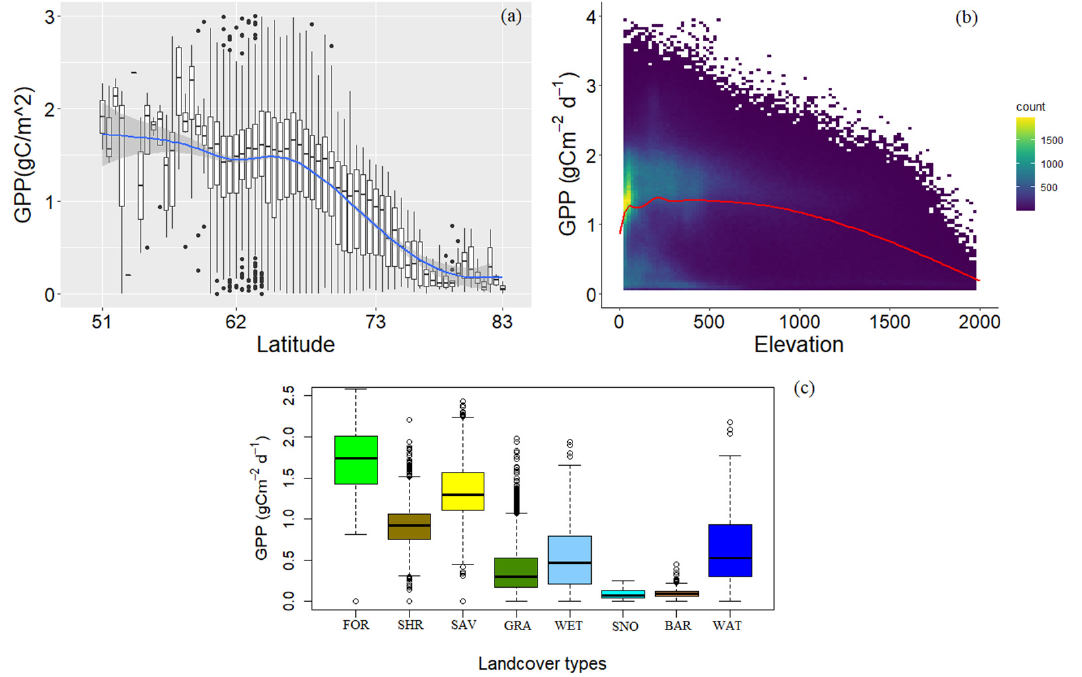
Figure 11. The annual-averaged GPP distribution with latitude ( a ) and elevation (m) ( b ) for the whole Arctic. The gray belt refers to the confidence interval of 95%, the blue line refers to the fit line, and the boxplots denote the distribution of the annual-averaged GPP with the latitude. ( c ) The annual-averaged GPP distribution for the entire study period 2001–2019 over different land cover types. FOR, SHR, SAV, GRA, WET, SNO, BAR, and WAT denote the forests, shrublands, savannas, grasslands, permanent wetlands, permanent snow and ice, barren, and water bodies, respectively.